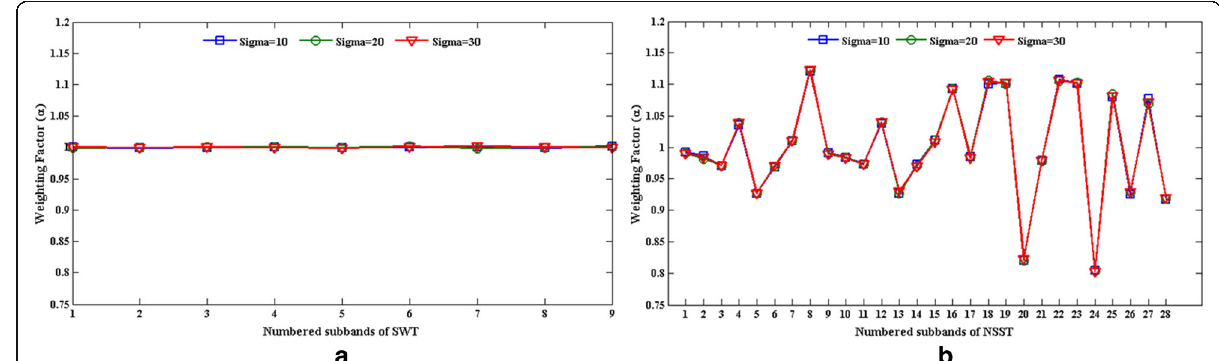
Fig. 7 Obtained weighting factor based on a flat image and for 80 independent trials: a SWT, and b